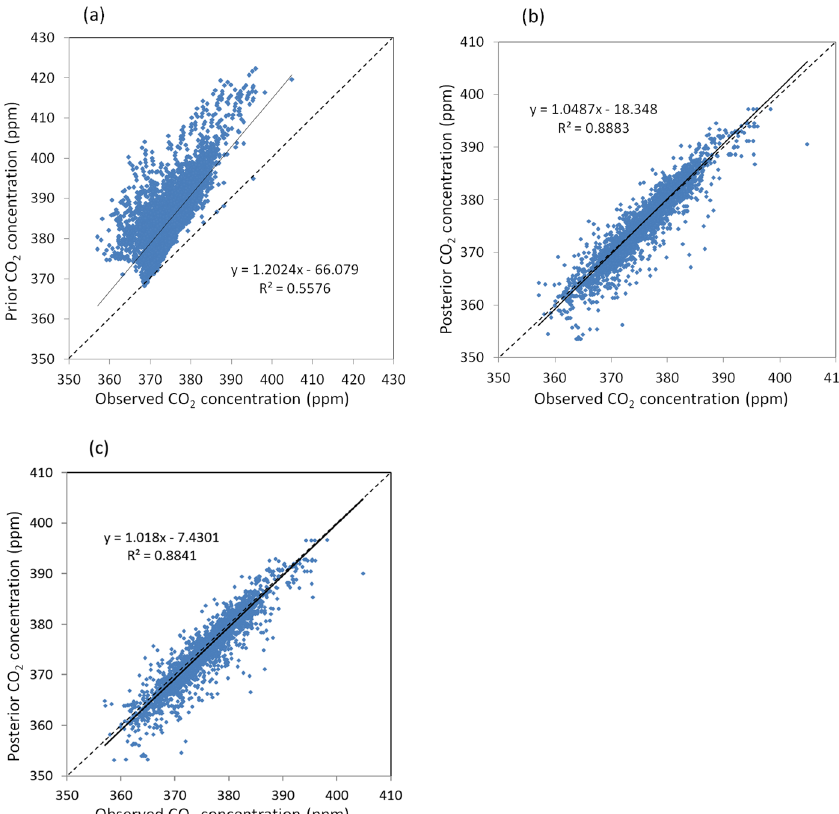
Figure 14. CO 2 concentrations from (a) prior, (b) posterior from the CO 2 -only inversion and (c) posterior from the joint inversion in comparison with observations. The prior concentration is obtained through transport modelling with prior CO 2 fluxes from the terrestrial ecosystems, oceans, fossil-fuel emission and biomass